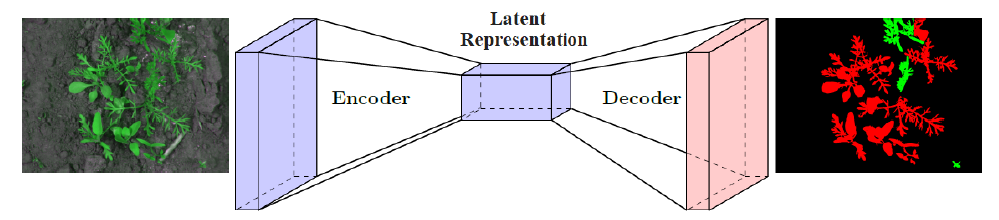
Figure 3. General structure of semantic segmentation based on